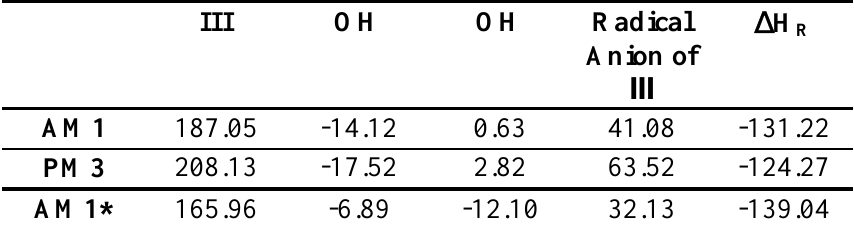
Table. Heat of formation (kcal mol -1